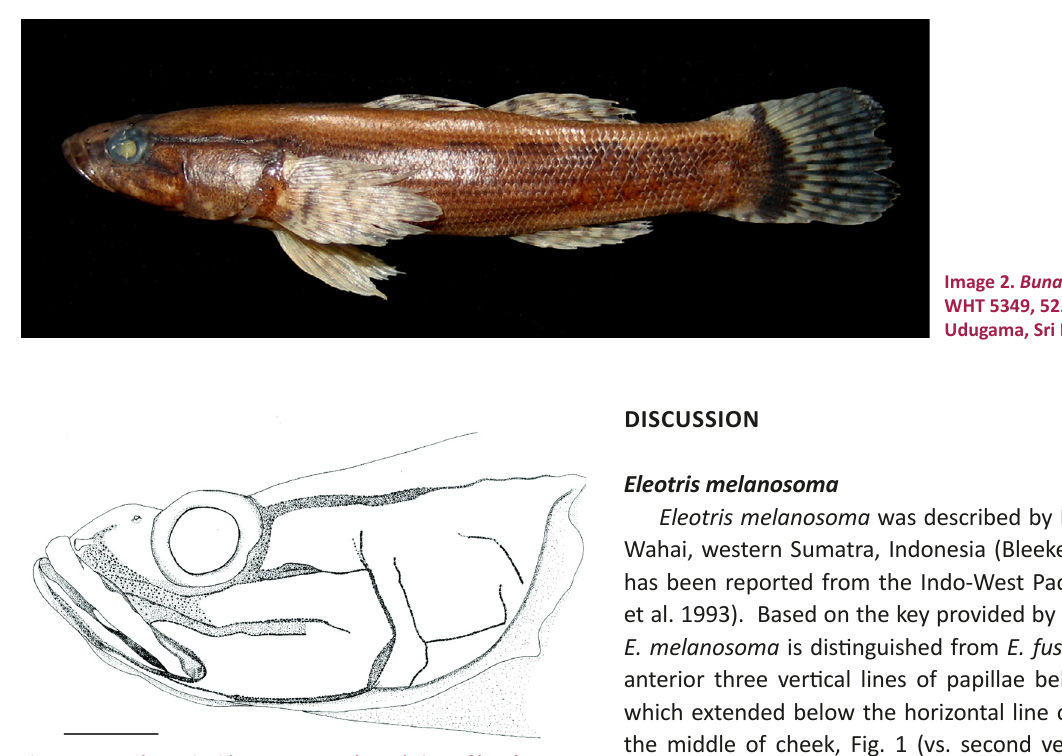
Figure 3. Bunaka gyrinoides, WHT 5349, lateral view of head showing sensory papillae. Scale bar: 5